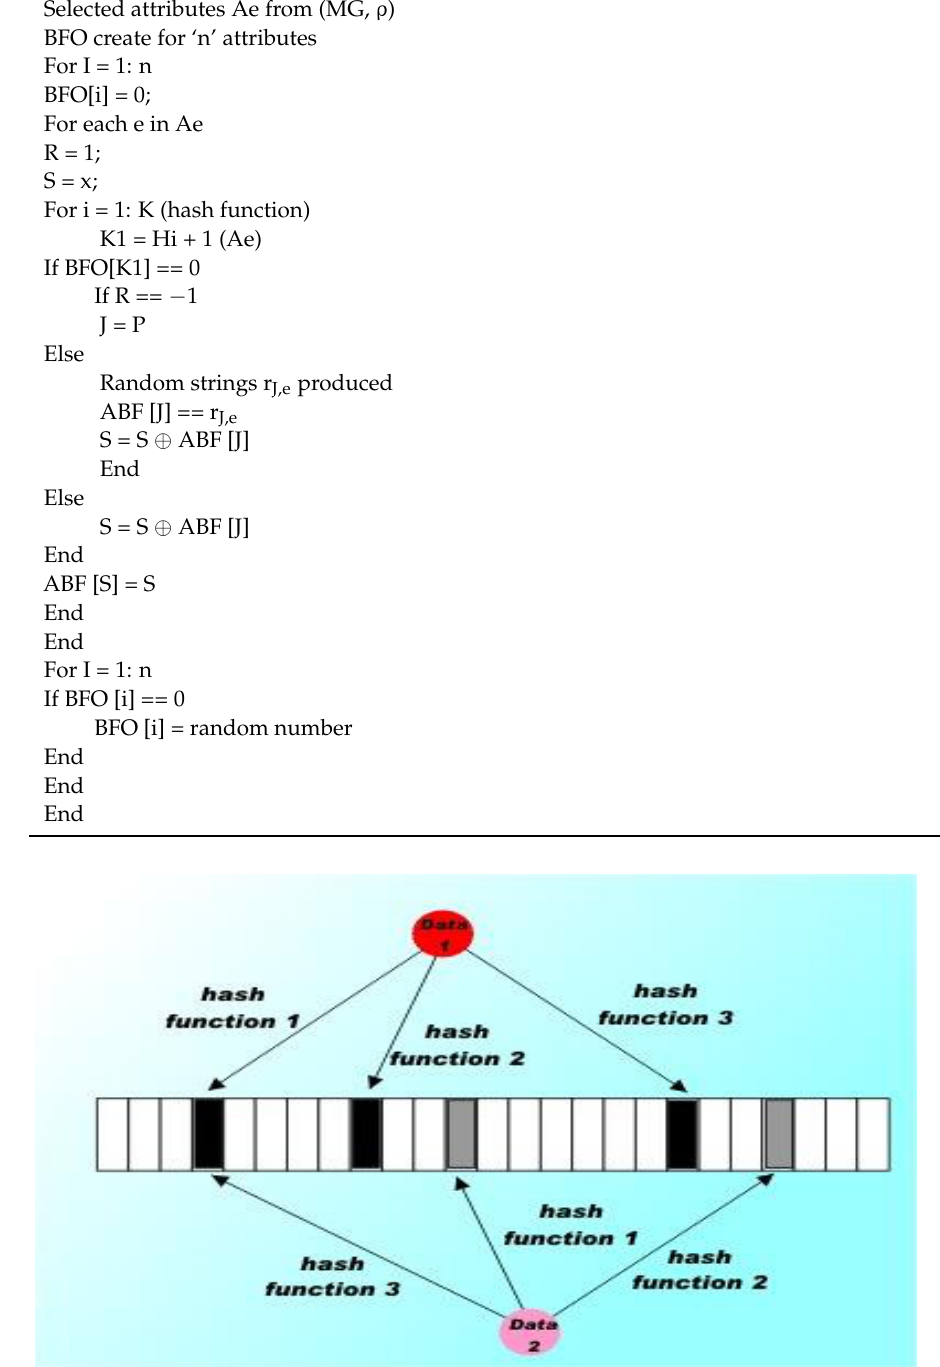
Algorithm 3: Attribute Extraction Using BF Reconstruction